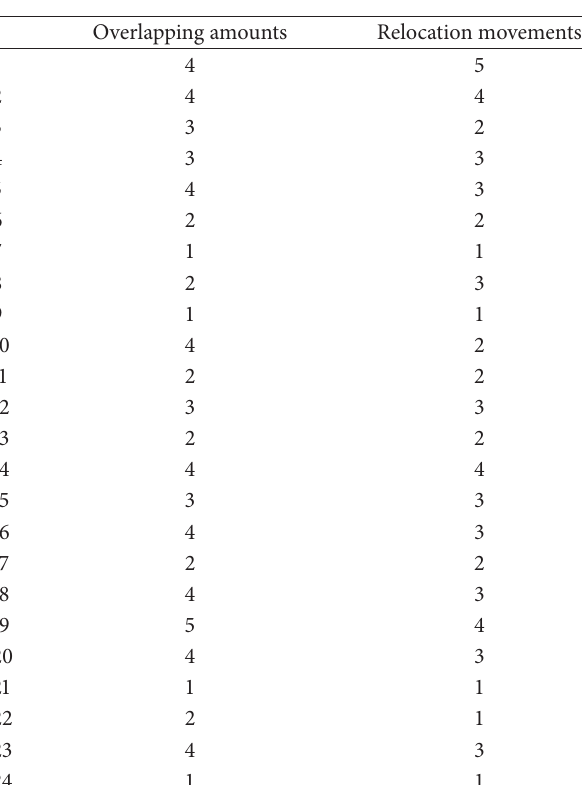
Table 4: Overlapping amounts and relocation movements for each